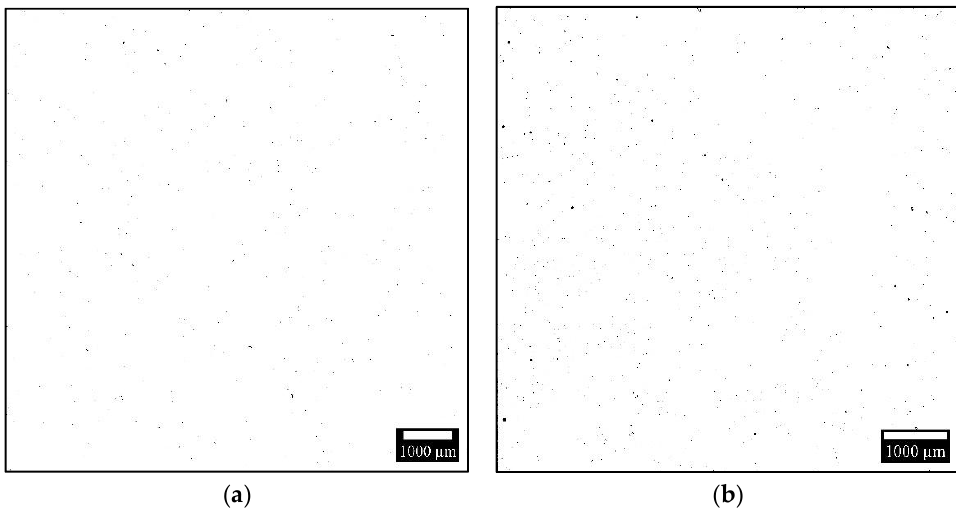
Figure 6. binary image of ( a ) L-PBF sample and ( b ) LMD sample for defect analysis.